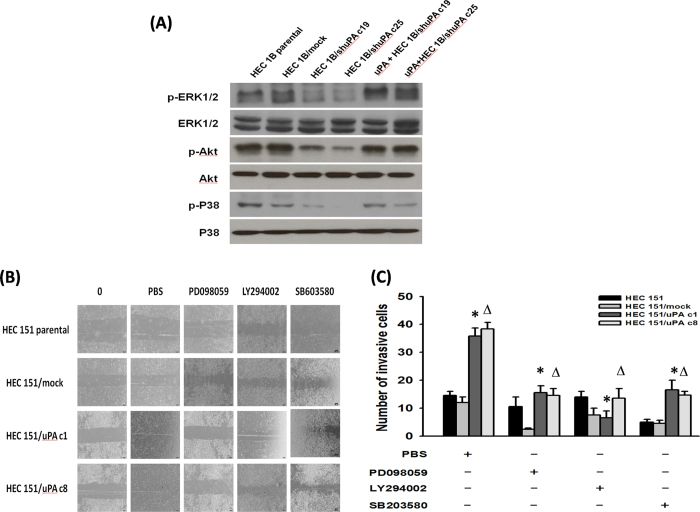
uPA could enhance the ERK1/2, Akt, or p38 phosphorylation and the migration and invasion of endometrial tumor cells could be blocked by respective inhibitor.(A) Western blotting analysis of phosphorylation of ERK1/2, Akt, JNK and p38 molecules in HEC1B/shuPA c19 and HEC1B/shuPA c25 cells treated with recombinant uPA. Note: The phosphorylation of ERK1/2, Akt and p38 was consistently upregulated in cells treated with recombinant uPA. (B) Representative images of migration assays in HEC151 parental cells and their uPA transfectants treated with respective ERK1/2, Akt, or p38 phosphorylation inhibitor. Note: Both HEC151/uPAc1 and HEC151/uPAc8 cells had fewer migrating cells when treated with respective inhibitor than those treated with PBS alone. (C) Bar graph depicting the number of invasive cells of HEC151 parental cells and their uPA transfectants treated with respective ERK1/2, Akt, or p38 phosphorylation inhibitor by Boyden chamber analysis. Note: Lower numbers of invasive cells in HEC151/uPAc1 and HEC151/uPAc8 cells treated with respective inhibitor than those treated with PBS alone. (*, Δ indicate p < 0.001, one-way ANOVA).